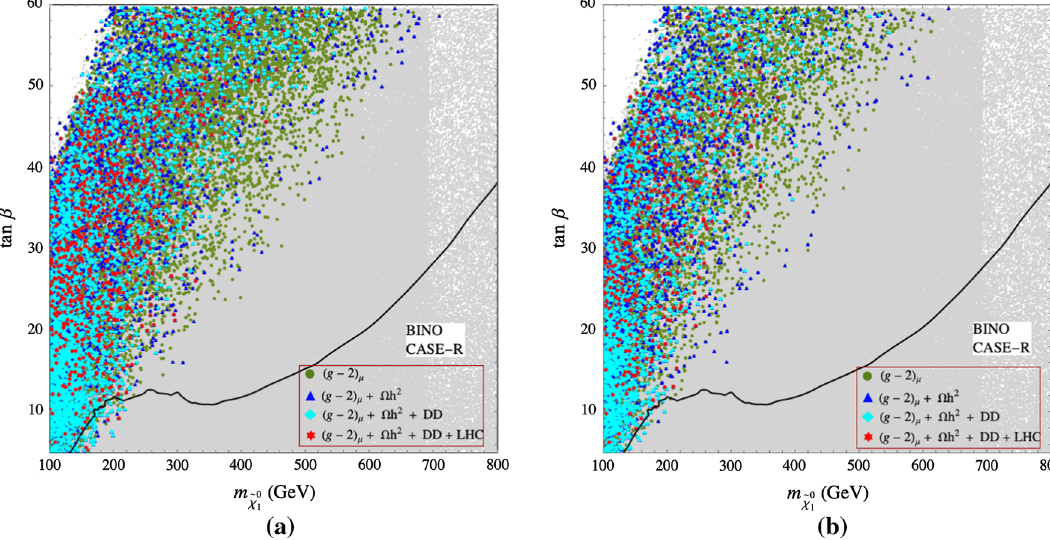
Fig. 21 The results of our parameter scan in the m ˜ χ 0 in the ˜ l -coannihilation case-R scenario for current (left) and antic- ipated future limits (right) from ( g − 2 ) μ . The color coding is